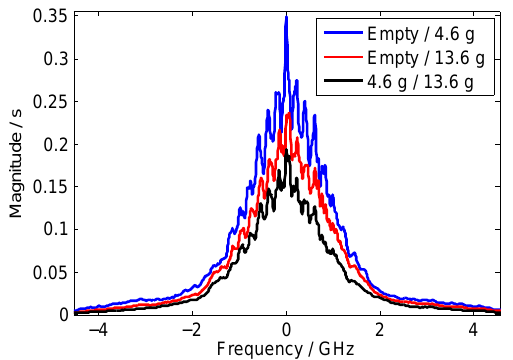
Figure 15. Cross-correlation functions of the UWB magnitude spectra in Fig. 12.